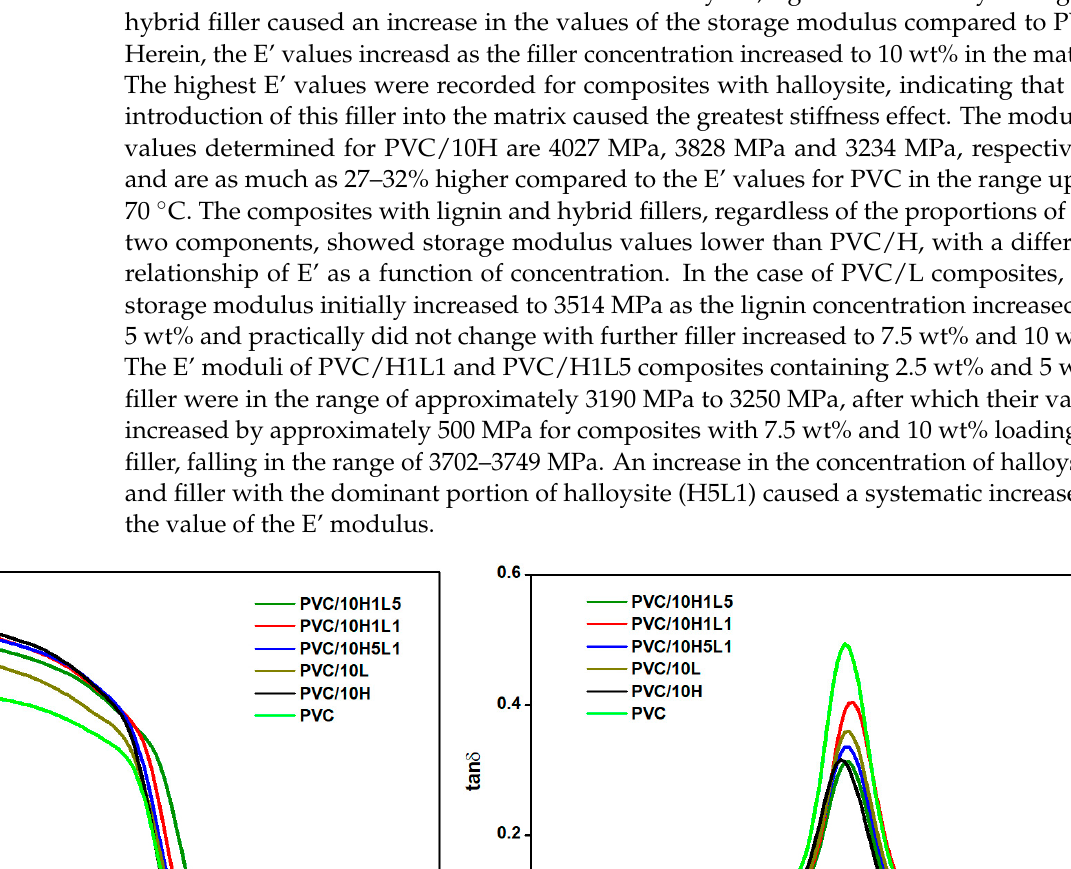
Figure 8. DMA thermograms of PVC and PVC composites with 10 wt% of fillers: storage modulus ( a ) and loss factor ( b ). Table 4. The storage modulus (E’) and glass transition temperature (T g ) of PVC and PVC compo- sites.